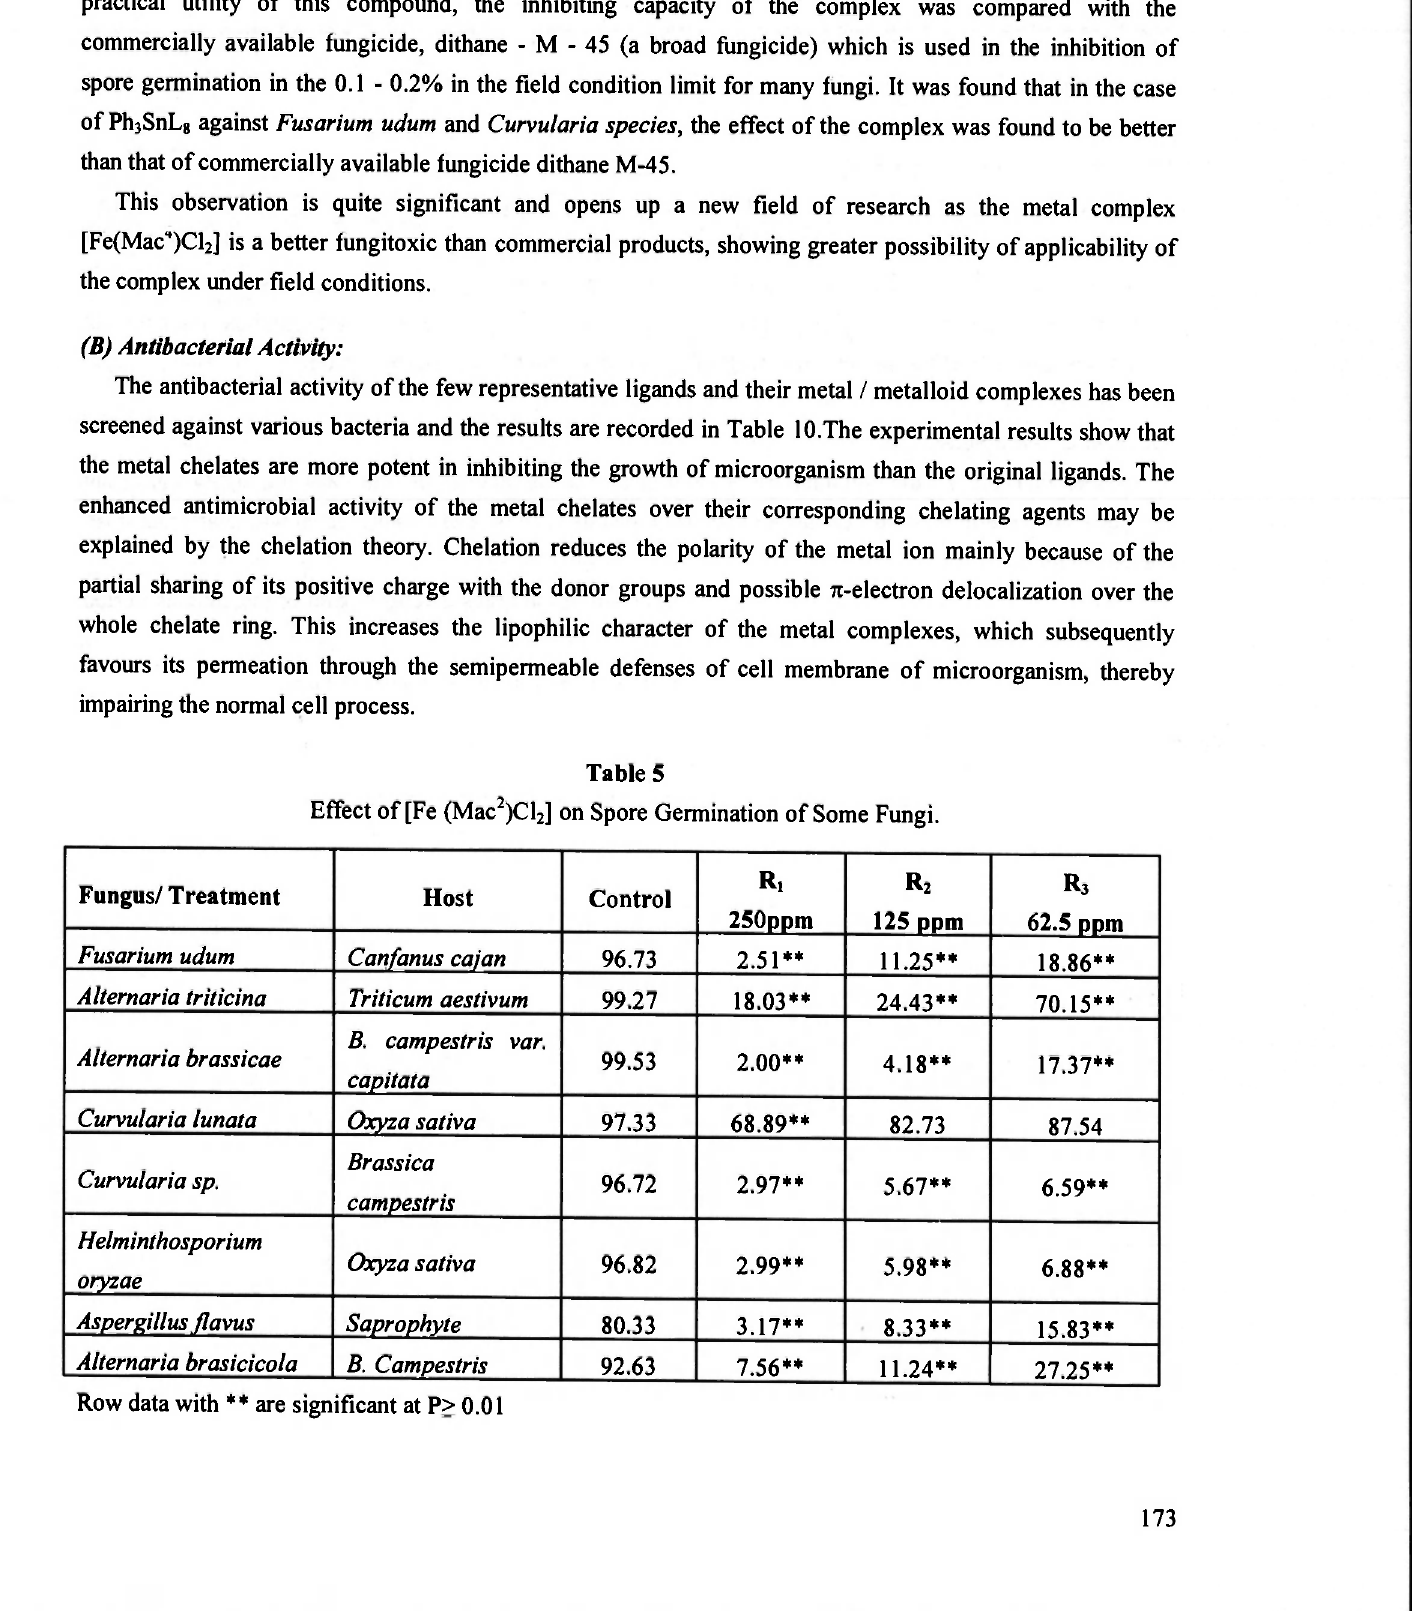
Effect of [Fe (Mac 2 )Cl 2 ] on Spore Germination of Some